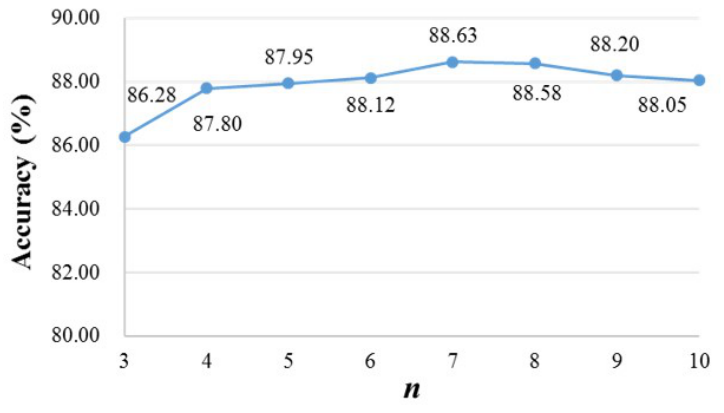
Figure 8. The recognition accuracy of MMFN with different n